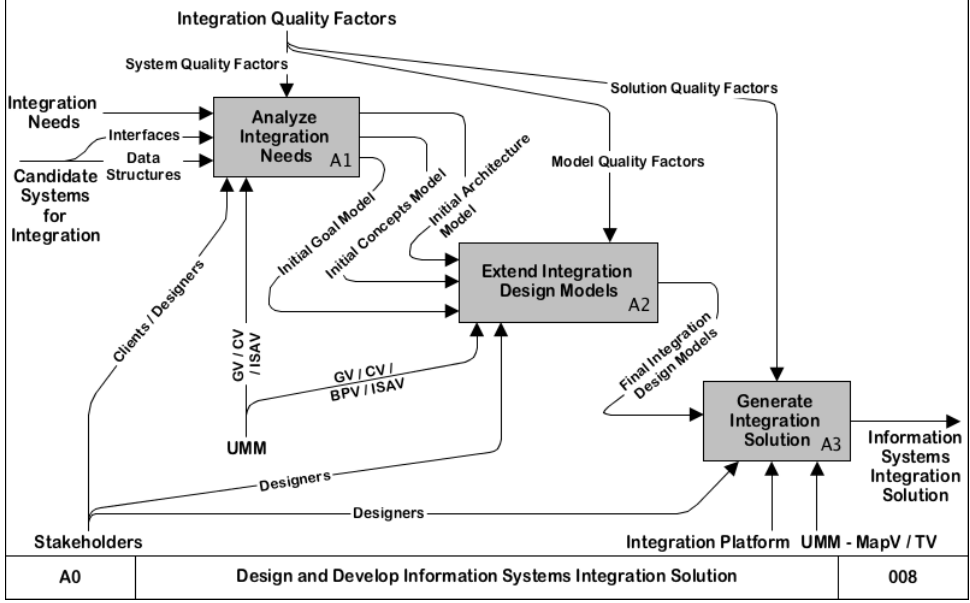
Figure 2. The main stages of the integration design methodology